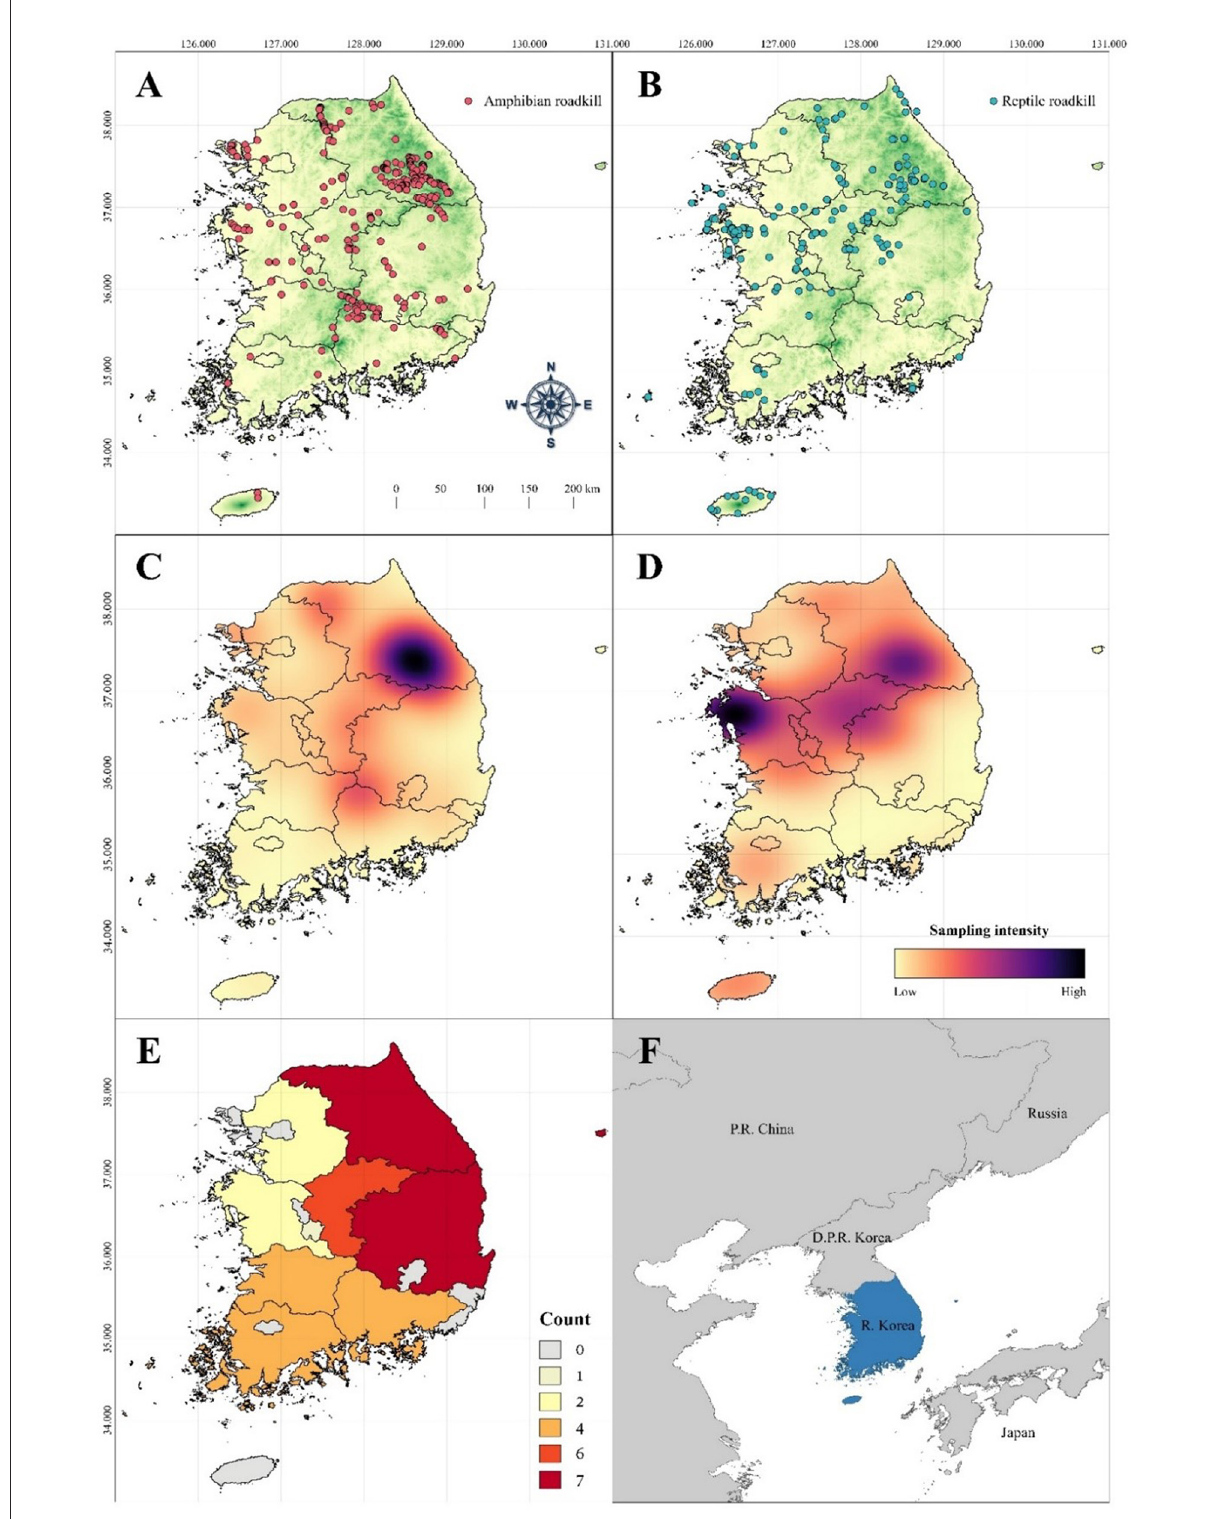
FIGURE2 Spatial distributions of herpetofauna roadkill observations across the Republic of Korea (R Korea). (A) GPS coordinates of the iNaturalist amphibian roadkill observations. (B) GPS coordinates of the iNaturalist reptile roadkill observations. (C) A kernel density map of the